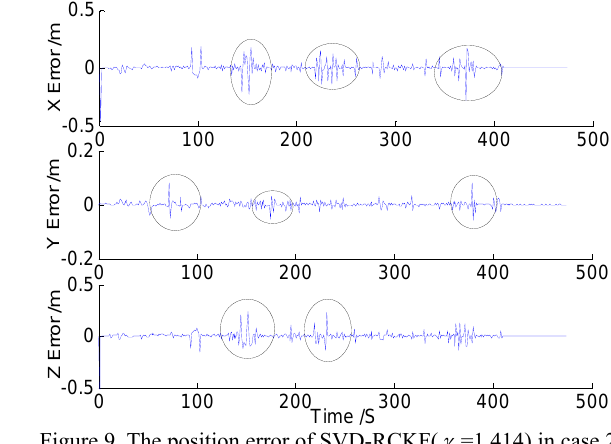
Figure 9. The position error of SVD-RCKF(  =1.414) in case 2